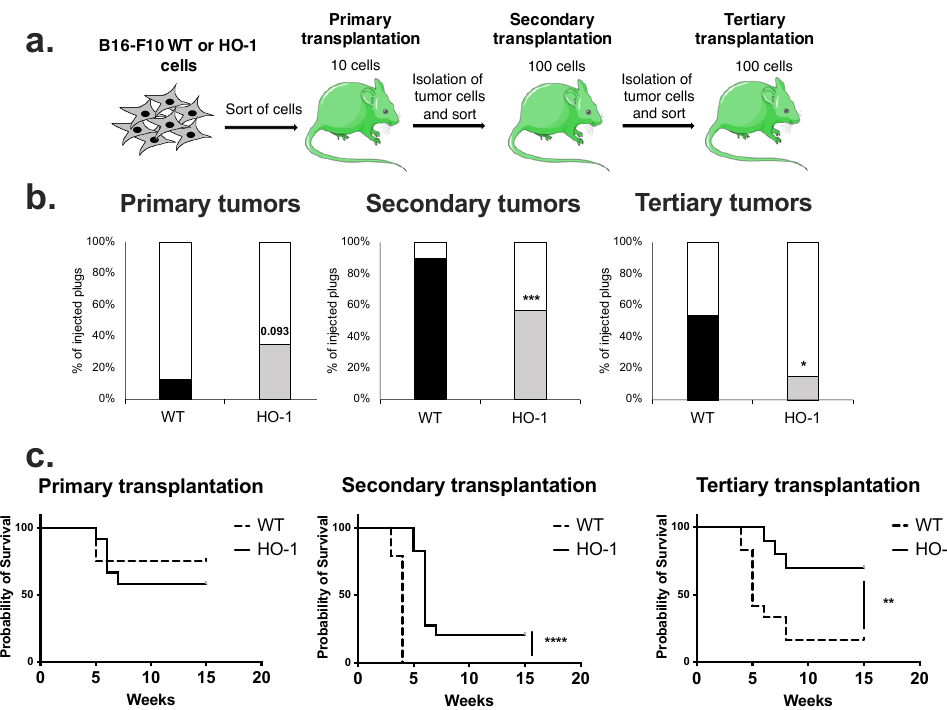
Figure 7. Serial transplantation of B16-F10 WT and HO-1 cells. ( a ) Experimental layout. Primary recipients (C57BL/6-Tg(UBC-GFP)30Scha/J mice) were injected with 10 sorted cells per Matrigel plug (2 plugs/mouse). After tumor formation, mice were sacrificed, tumors were excised, and GFP − /7AAD − /Hoechst + cells were sorted and transplanted (100 cells/plug) to the secondary recipients. ( b ) Efficacy of tumor formation represented as % of injected plugs/mouse (pri- mary recipients n = 12 mice/group, secondary recipients n = 29 mice/group, tertiary recipients n = 10–13 mice/group; Fisher exact test; * p < 0.05, *** p < 0.001 versus WT). ( c ) Survival curve of mice. Mice were sacrificed when tumors reached 10 mm in diameter (Mantel–Cox test; ** p < 0.01, **** p <